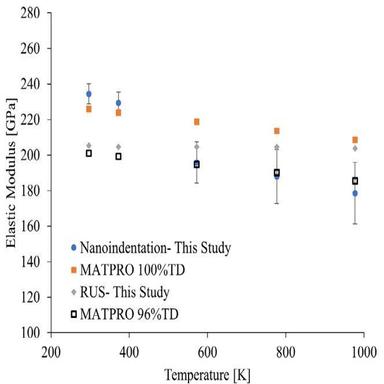
Young's modulus vs. temperature as determined by nanoindentation, RUS, and MATPRO correlations corrected for density for UO2.